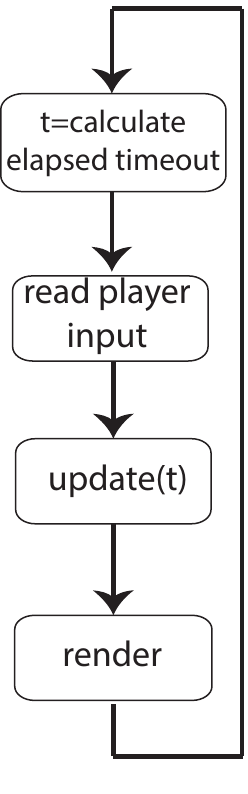
Figure 2. Single-Thread Uncoupled Model.